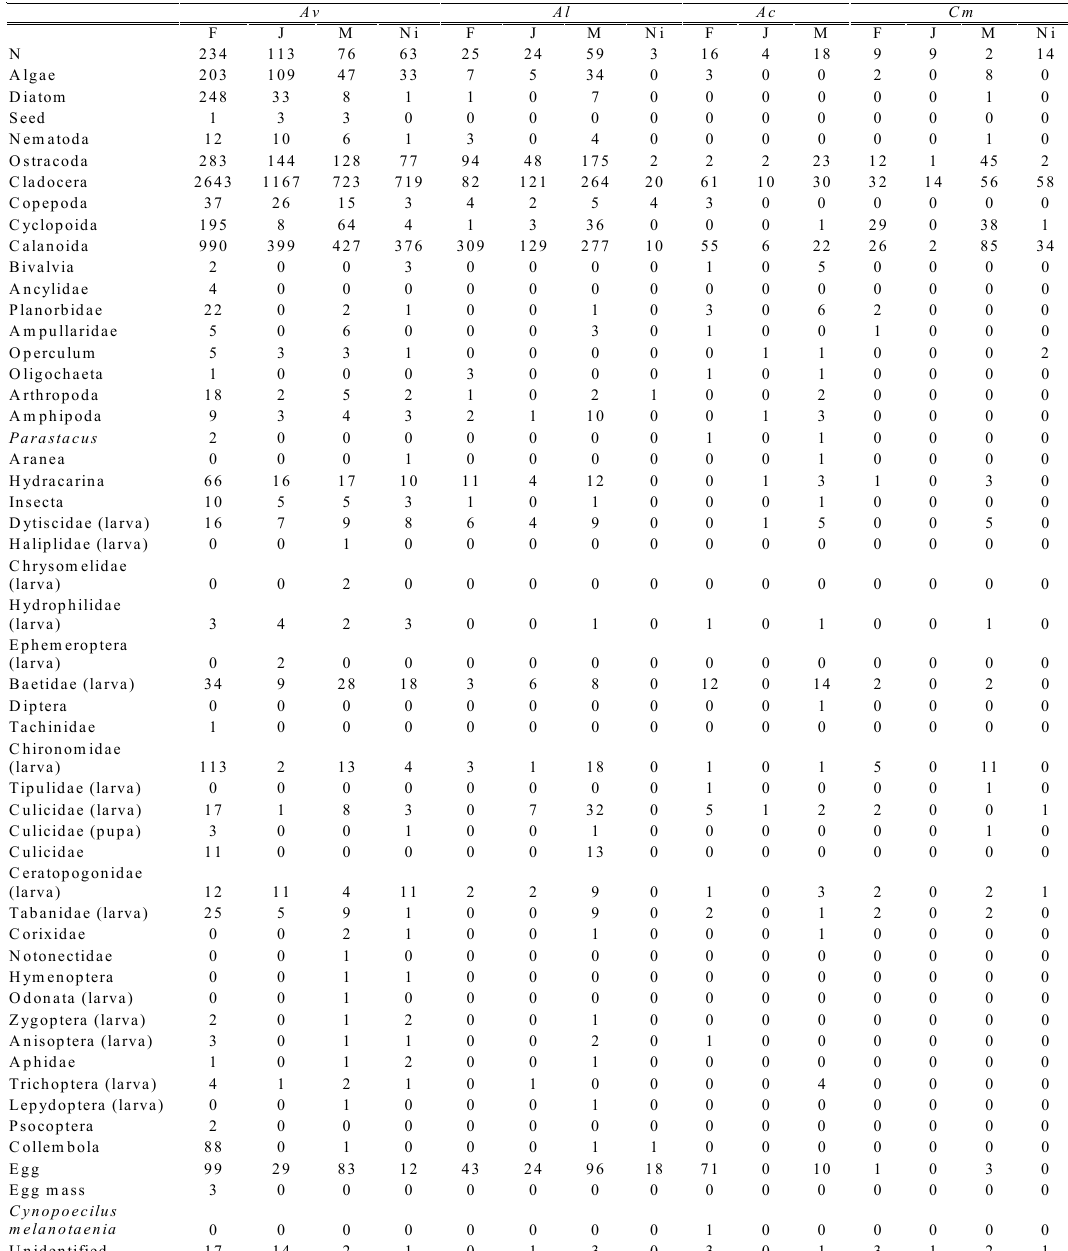
Table 1. Diet of A. viarius ( Av ), A. luteoflamulatus ( Al ) , A. cheradophilus ( Ac ) and C. melanotaenia ( Cm ) from temporary pools at Castillos lagoon basin, southeastern Uruguay. Gut content is presented for females (F), males (M), juveniles (J) and not identified individuals (Ni). The first line (N) details the number of analyzed fishes for each species and demographic